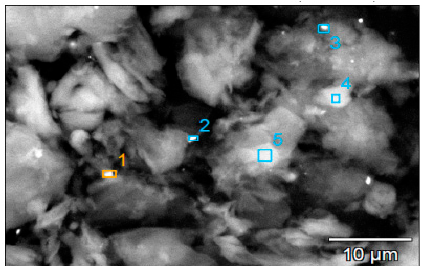
Figure 8. SEM picture of Pd/GO-B. The content of Pd ranged from 0.23 to 2.99 atom% and the Cl content was 0.21–0.28 atom%.